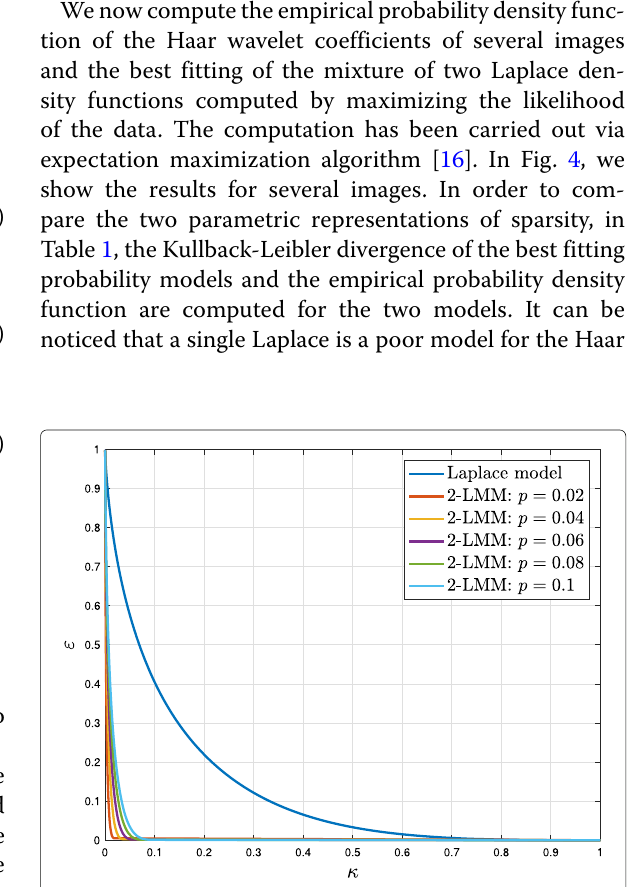
Fig. 3 Experiment 2: comparison of compressibility parameters (κ , ε) for several priors. Laplace distribution is not a compressible distribution, whereas for 2-LMM distribution if parameter p is small and α << β we can have both κ and ε small at the same time. In this case α = 0.1, β = 10, and p ∈